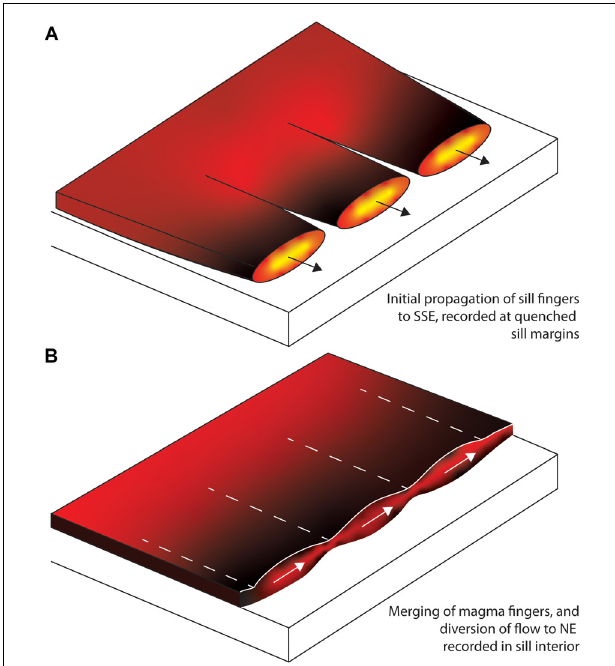
FIGURE 11 | Schematic diagram of initial sill emplacement as magma fingers which propagated to the SSE (A) , which subsequently coalesced with diverted flow direction towards the NE (B)